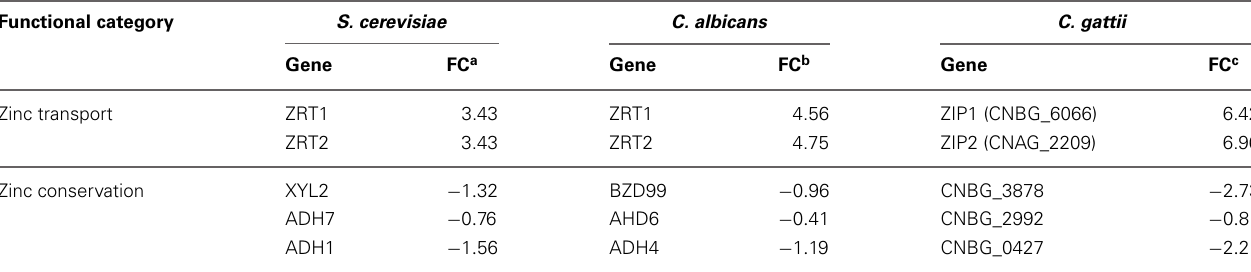
Table 1 | Common set of genes regulated by Zap1 orthologs in yeasts. Functional